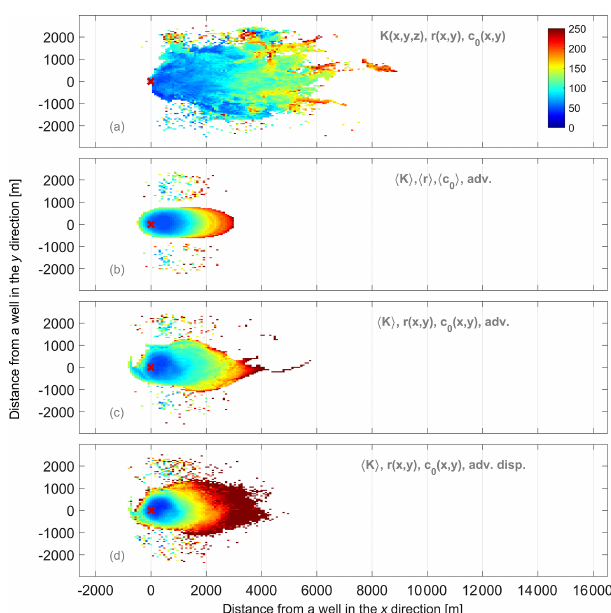
Figure 9. Expected travel time (years) of a particle leaving a given grid cell and reaching a well for a heterogeneous K field, hetero- geneous r and heterogeneous c 0 (reference case, a ); an upscaled K value, averaged r and averaged c 0 accounting for advection only (b) ; an upscaled K value, heterogeneous r and heterogeneous c 0 accounting for advection only (c) ; an upscaled K value, hetero- geneous r and heterogeneous c 0 accounting for advection and dis- persion (d)